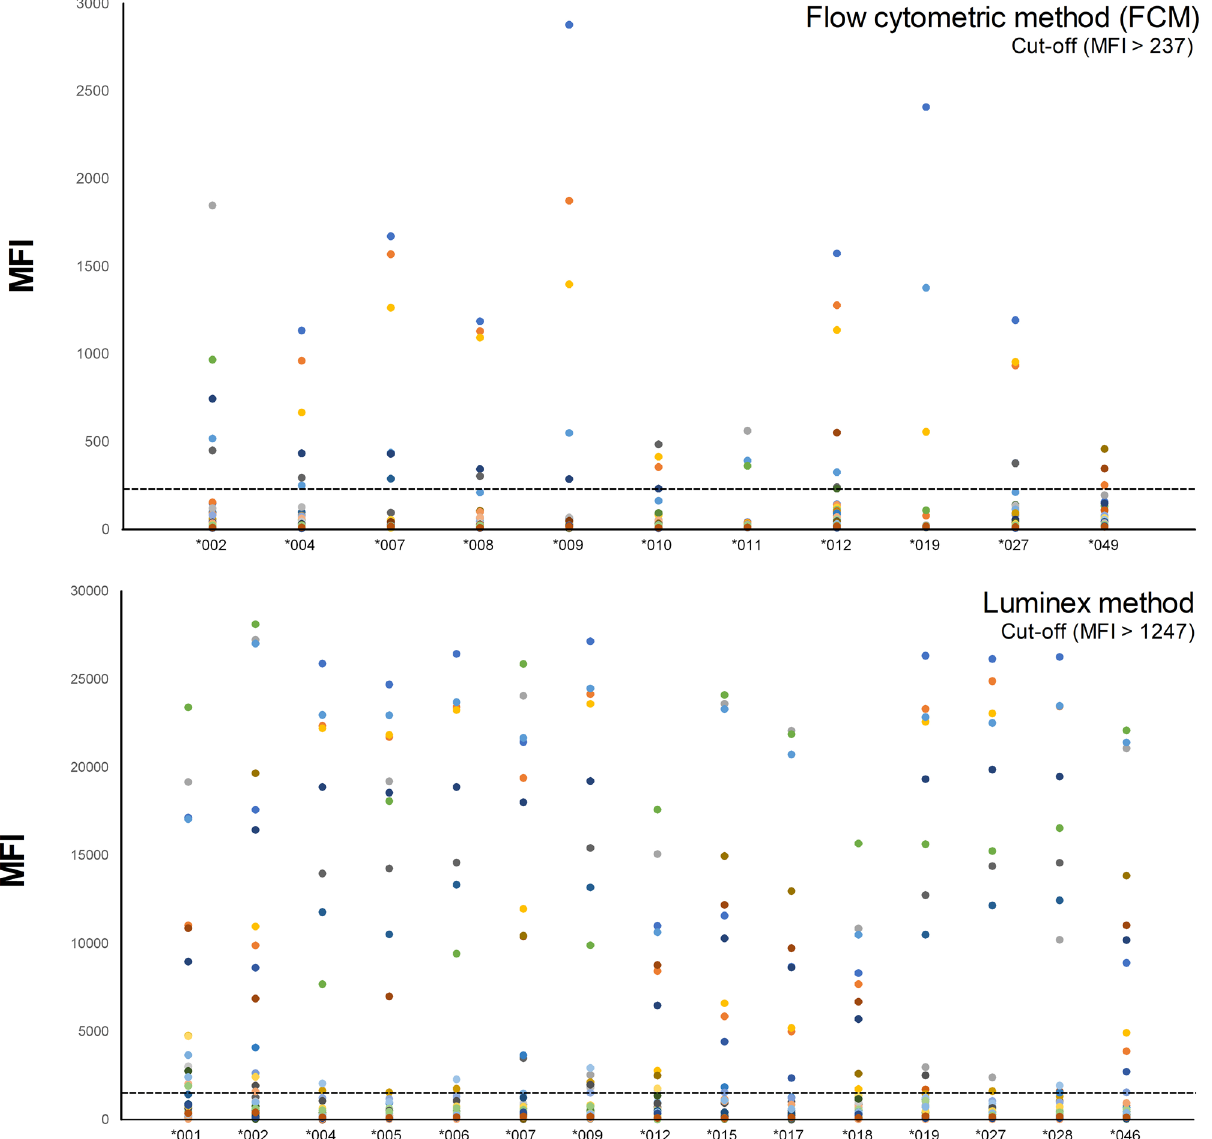
Figure 4. Response analysis for each MICA allele and flow cytometric method (FCM), Luminex method using positive sera from kidney transplant patients (n = 44). Both FCM and Luminex method displayed serum responses in allele order. As for Luminex method, the allele showing the strongest response was MICA*002, and, as for FCM, MICA*009 was identified as the allele showing the strongest